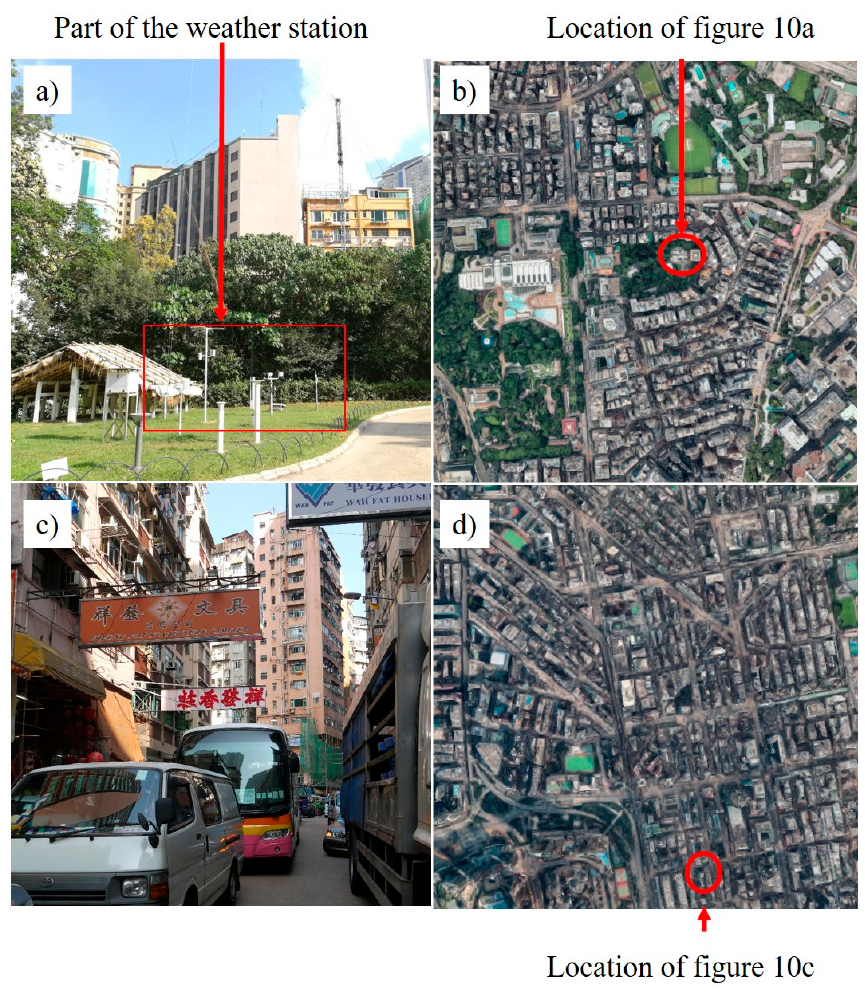
Figure 12. ( a ) A picture of the surrounding environment, taken by the author; ( b ) an aerial photograph of the location around the HKO station from Google map; ( c ) a picture of the surrounding environment, taken by the author; and ( d ) an aerial photograph of the location in the street from Google map. Table 3. The different parameters used for the temperature simulation in the station and streets. Green Area Ratio Frontal Area Ratio ( λ f ) Plan Area Ratio ( λ p ) H/W U E (m/s) q (m 3 /s) Station 0.40 0.50 0.30 6 0.0947 4.1255 × 10 6 Street 0.16 1.80 0.54 6 0.0824 2.4910 × 10 6